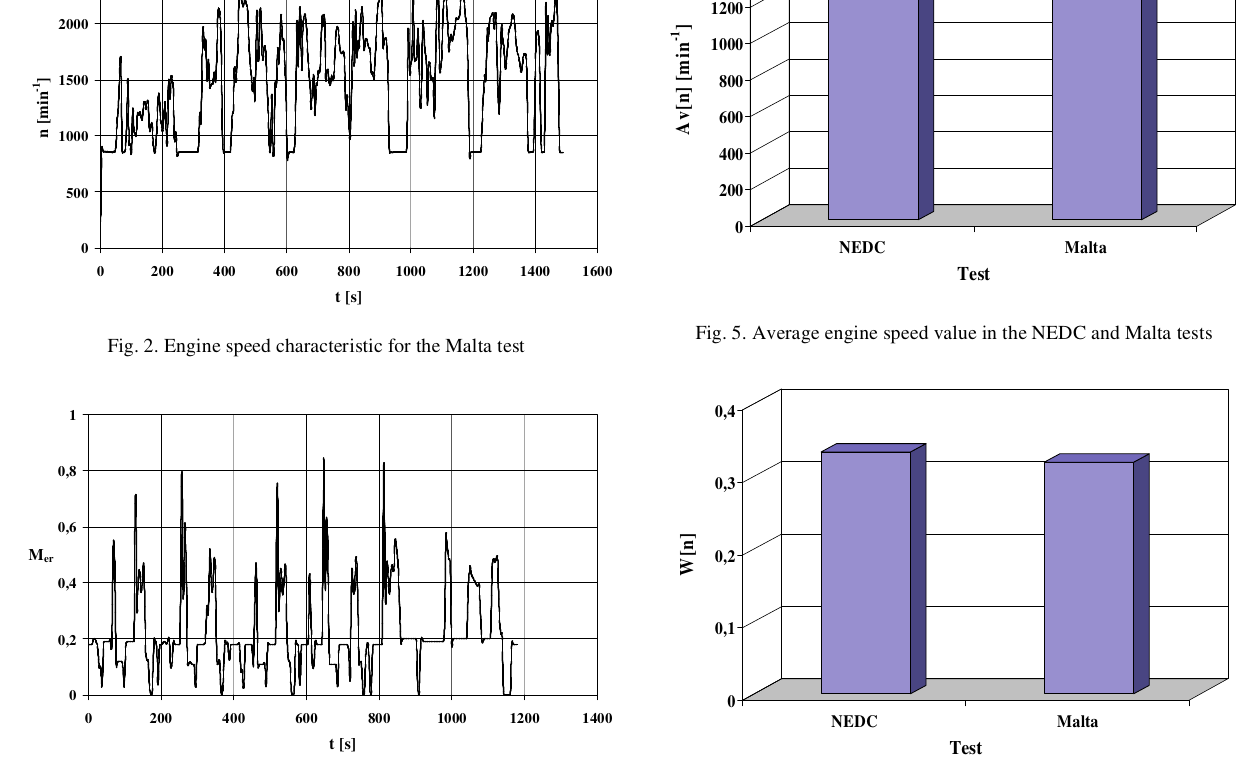
Fig. 3. Relative torque characteristic for the NEDC test